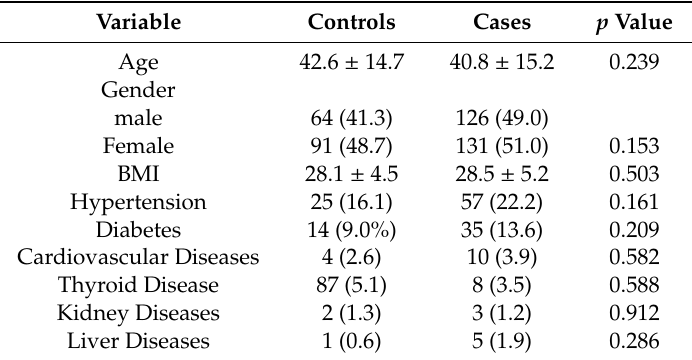
Table 1. Demographics and clinical characteristics of